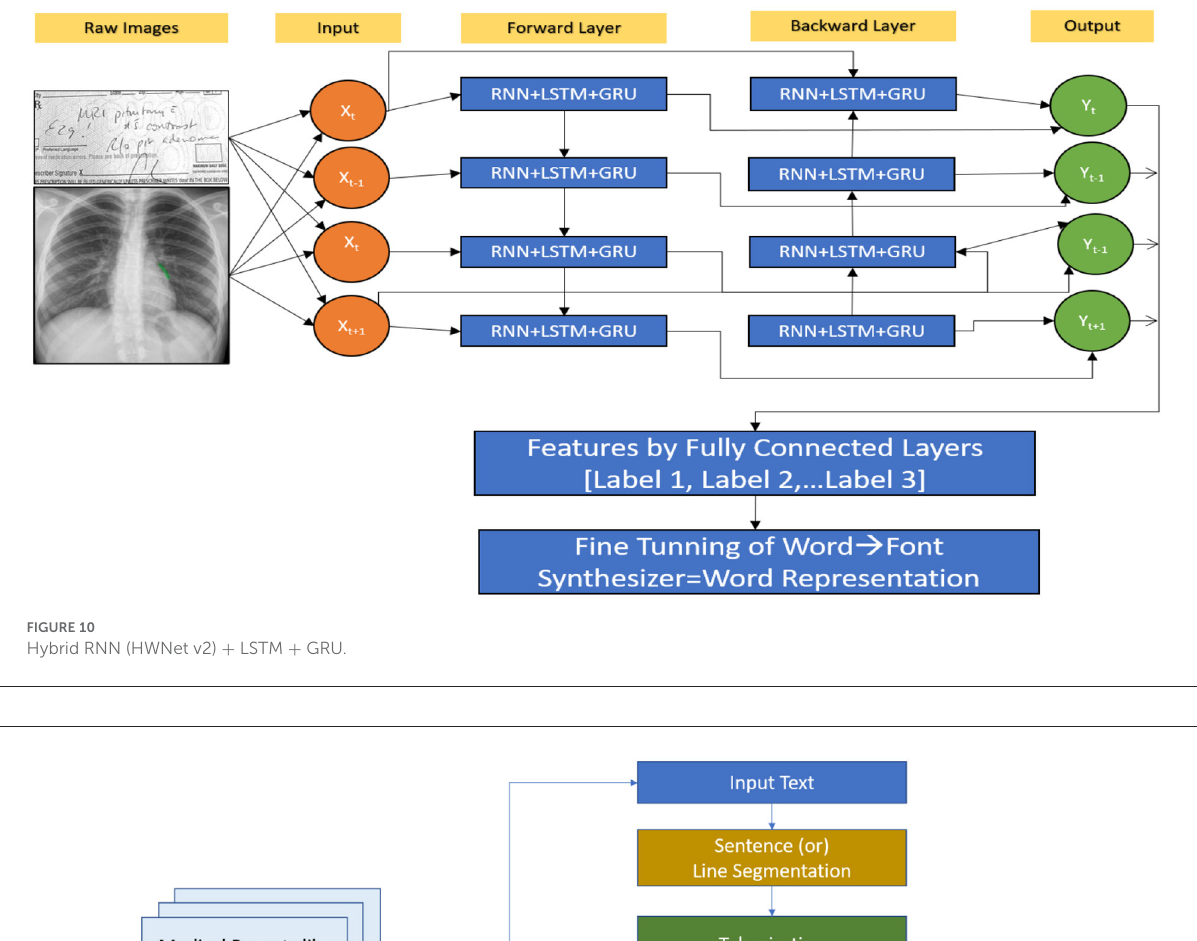
FIGURE10 Hybrid RNN (HWNet v2) + LSTM + GRU.